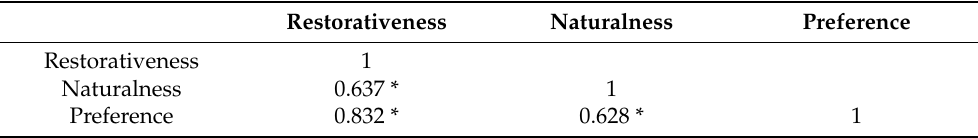
Figure 2. The aesthetic preference, restoration potential, and perceived naturalness of 10 images ( n = 93); Mean ± error. Table 6. Correlation analysis